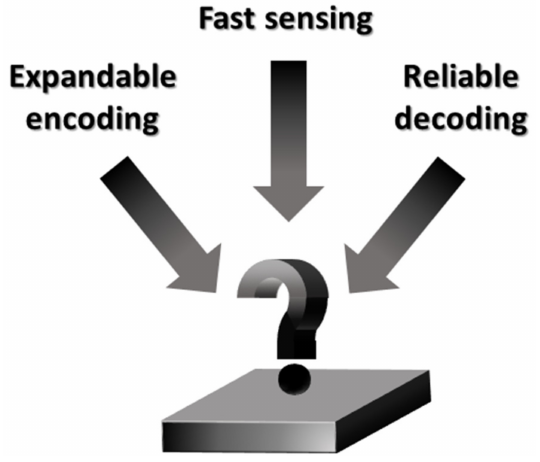
Figure 1. A flowchart rendering the essential merits for